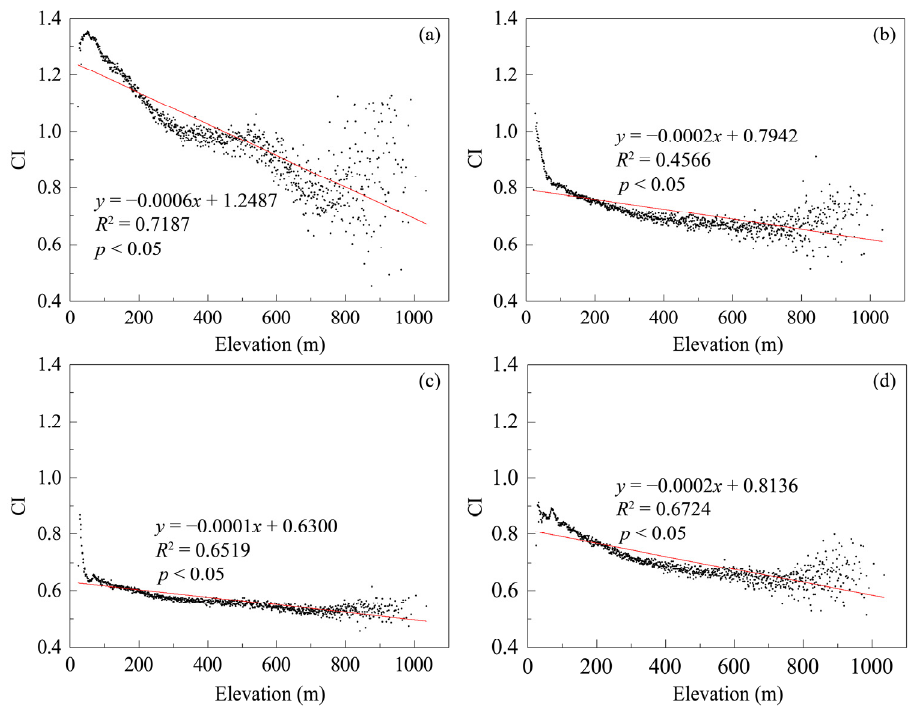
Figure 10. Variation trend of CI with elevation in each season: ( a ) winter; ( b ) spring; ( c ) summer; and ( d ) autumn.